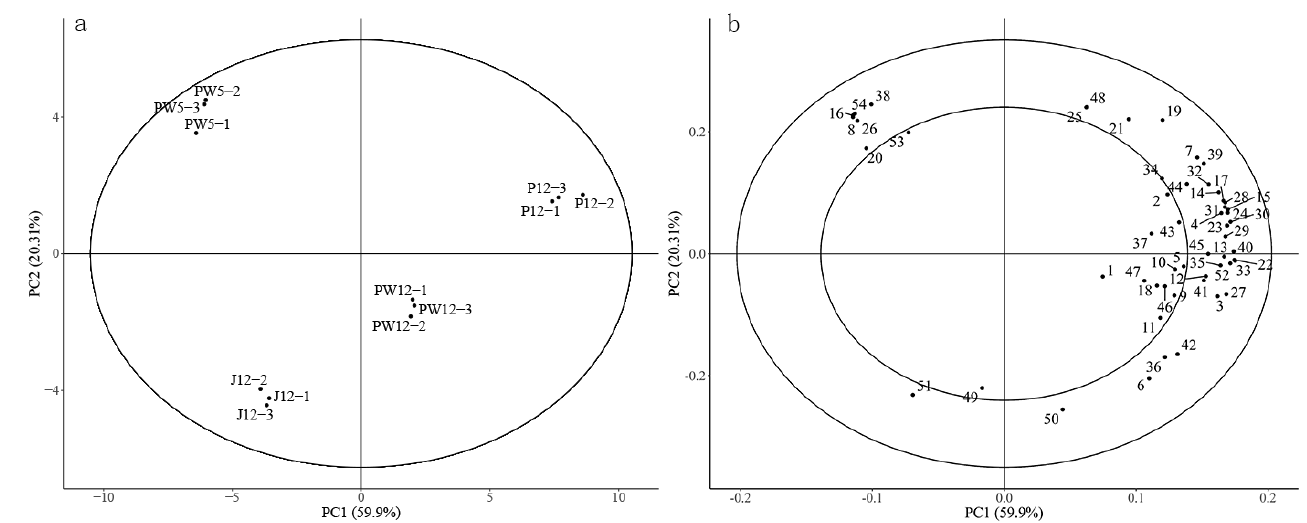
Figure 3. Principal component analysis of free volatile compounds in the investigated wines. PCA scores ( a ) and correlation loading ( b ) plots.